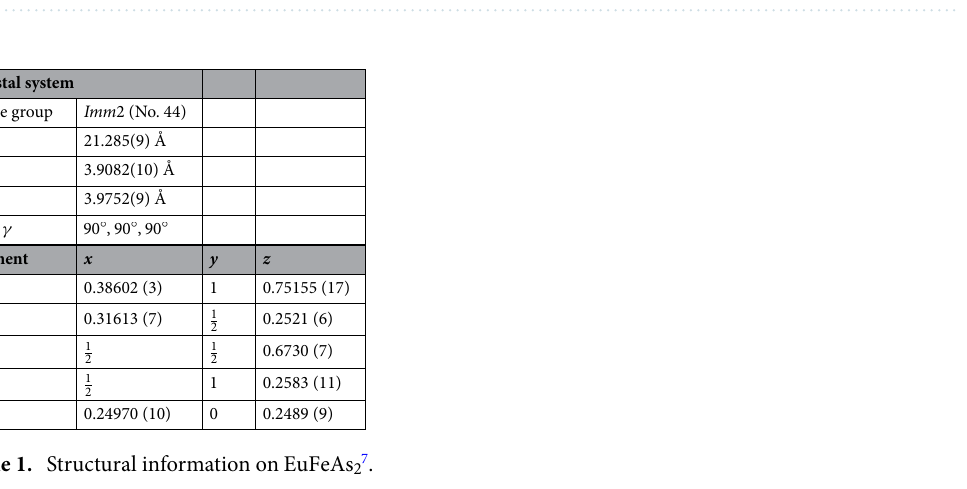
Figure 1. The unit cell ( a ) and the layered structure ( b ) of EuFeAs 2 . SigmaPlot v14, www. systa tsoft ware. com.